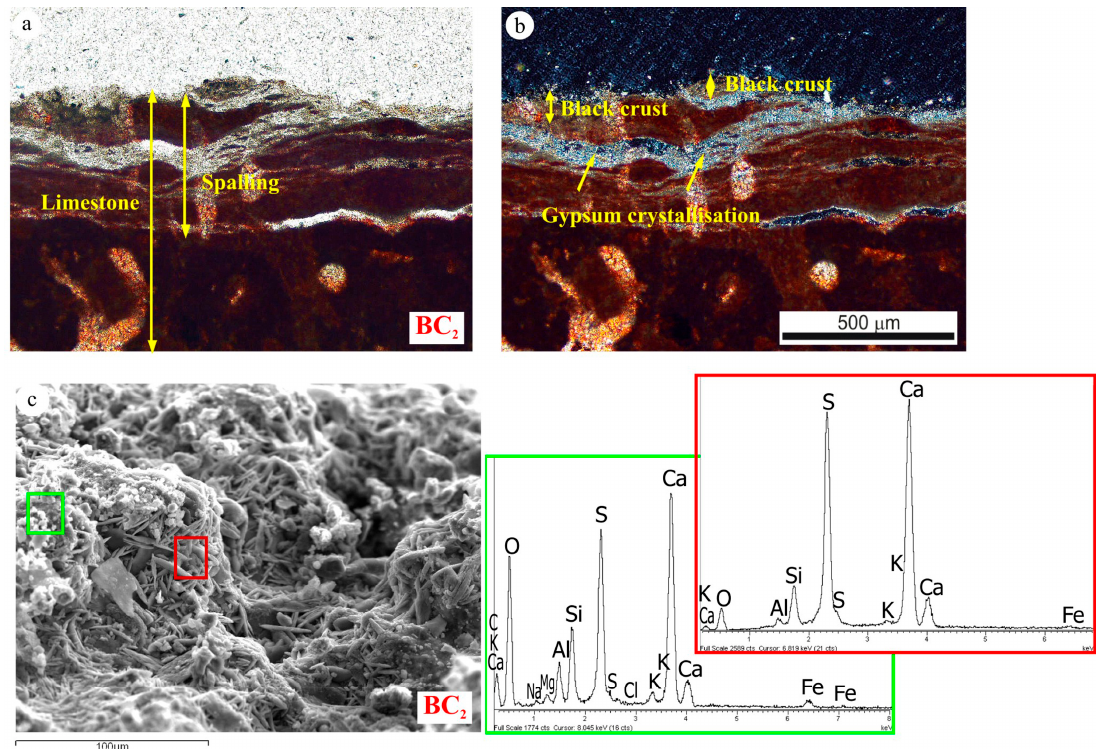
Figure 6. Black crust on limestone characterized with a polarizing optical microscope under ( a ) plane and ( b ) polarizing light; and ( c ) a scanning electron microscope fitted with an energy dispersive X-ray spectrophotometer.